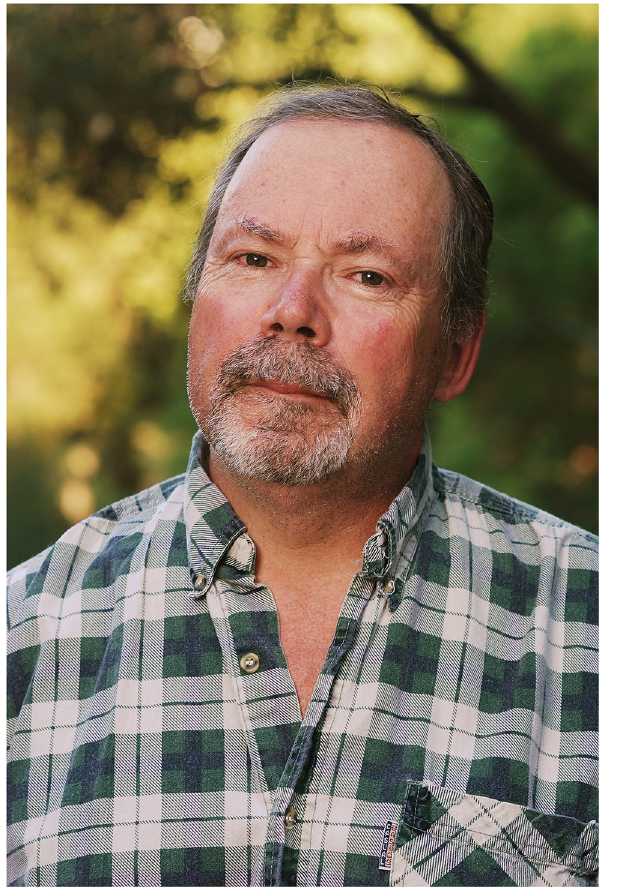
Fig 1. Philip E. Bourne. Associate director for data science,